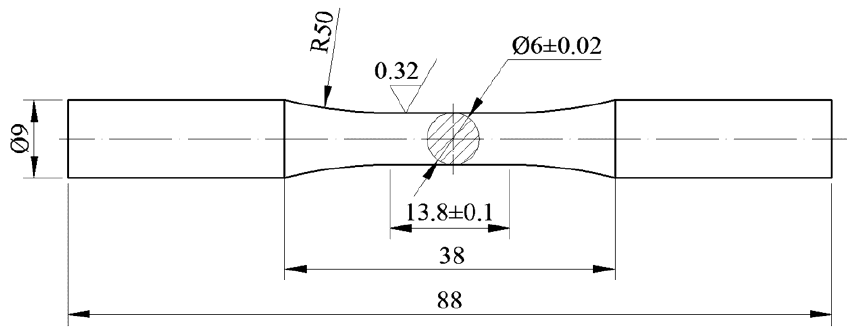
Figure 1. Geometry of the LCF test sample, all dimensions are in mm.